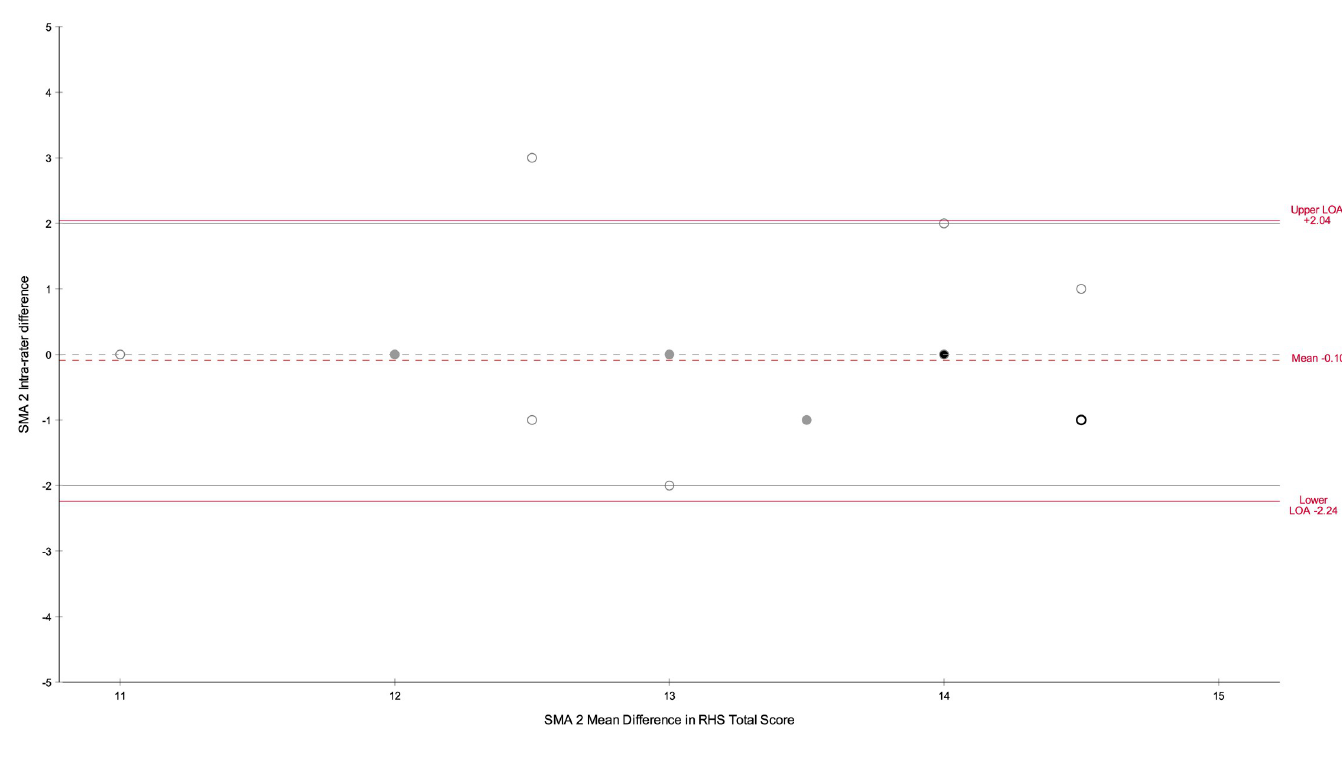
Fig 2. SMA 2 Intra-rater Bland Altman plot. Grey dotted line indicates 0 mean difference between tests, grey solid lines indicate the expert set limits of agreement. Dots– grey outline 1 rater, black outline 2 raters, grey filled dot 3 raters, black filled dot 4 raters.